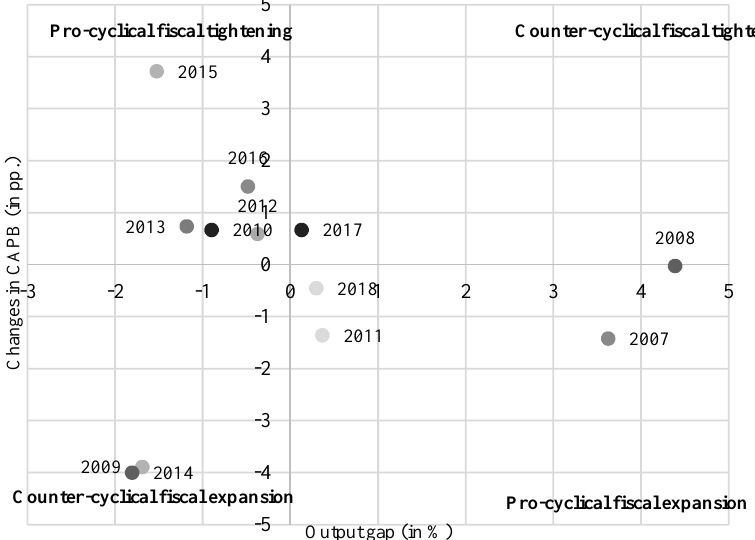
Figure 3. Types of fiscal policy in Bulgaria in